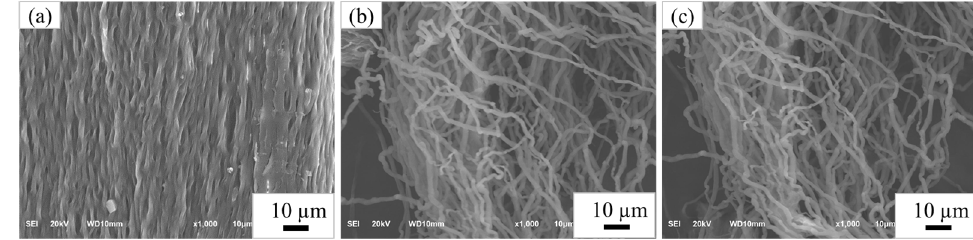
Figure 6. SEM micrographs (×1000) of bleached sample ( a ) first step, ( b ) second step, and ( c ) third step.